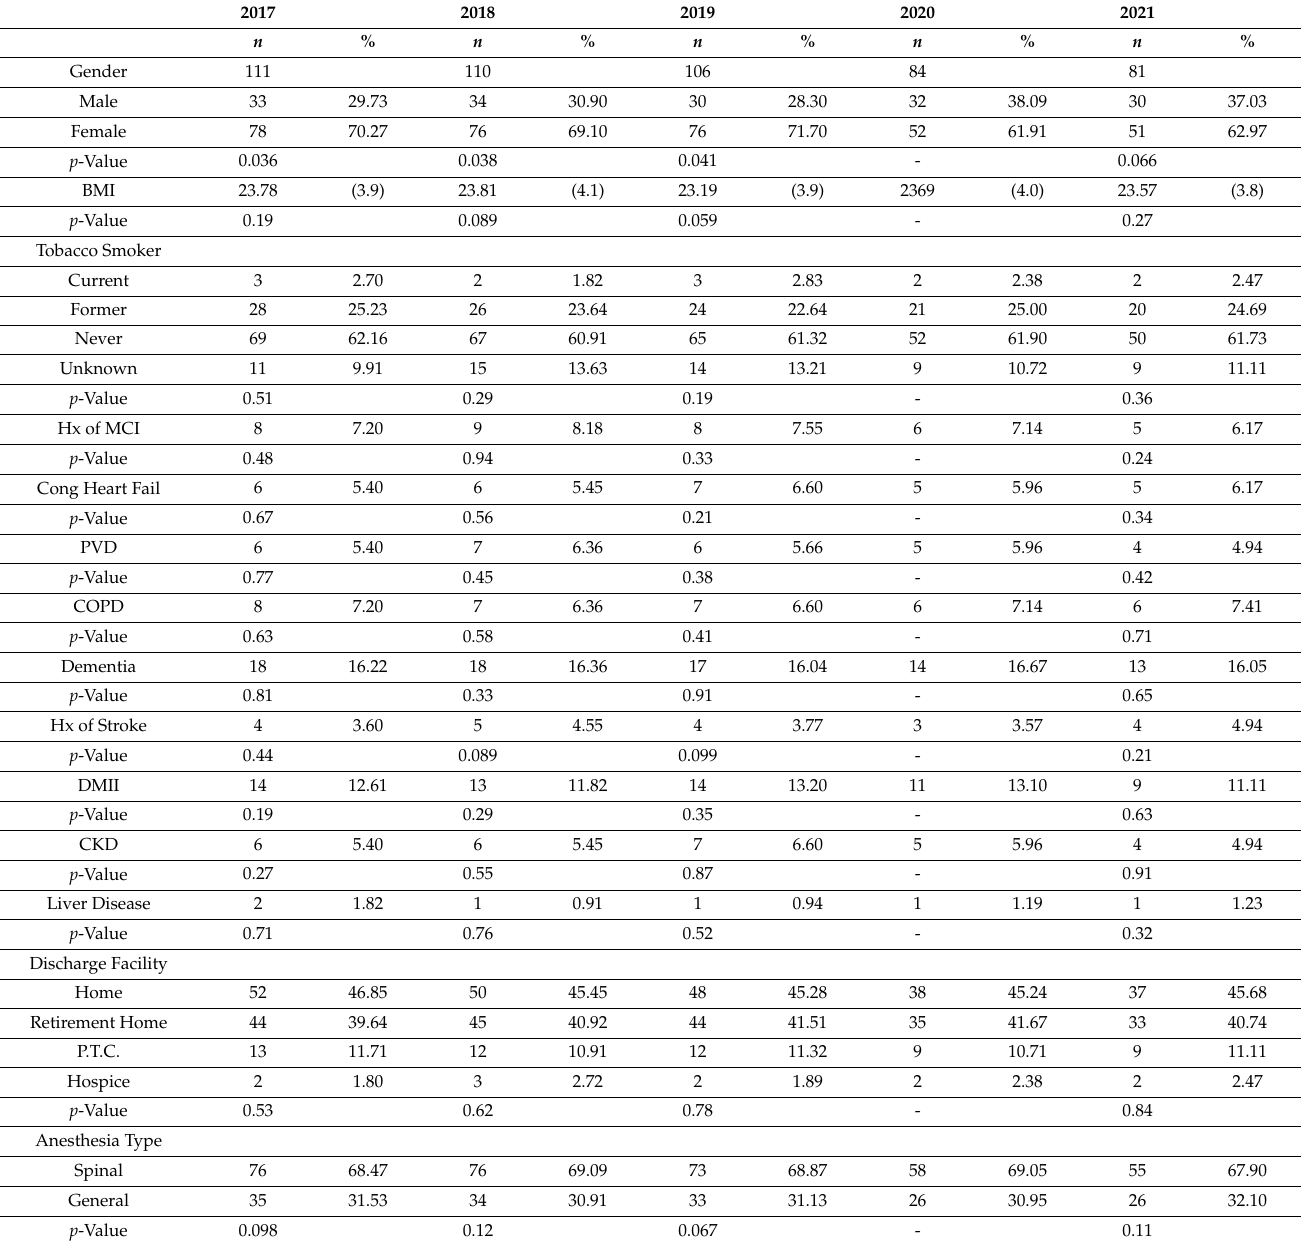
Table 5. Epidemiological and demographic